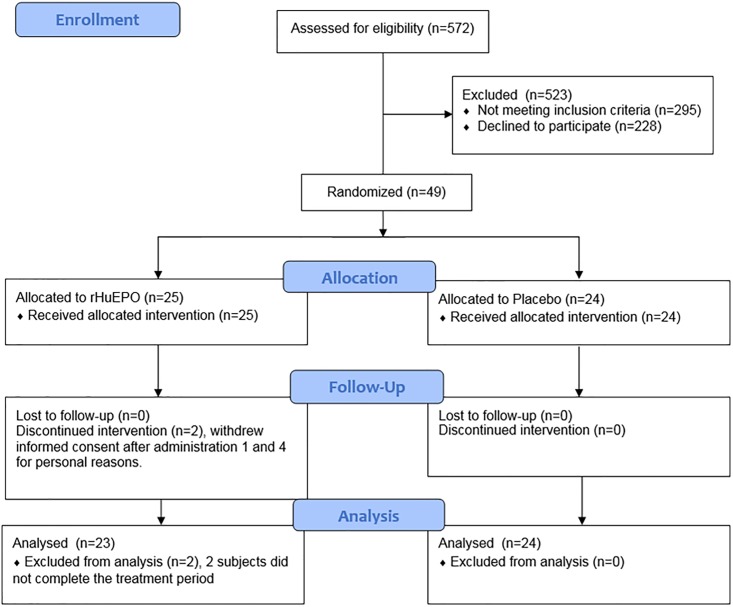
CONSORT flowchart.